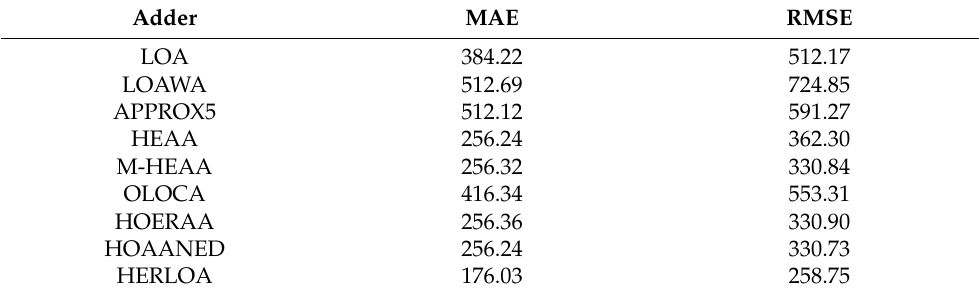
Table 2. Error metrics calculated for approximate adders for a size of 21-bits with a 11-bit inexact part.